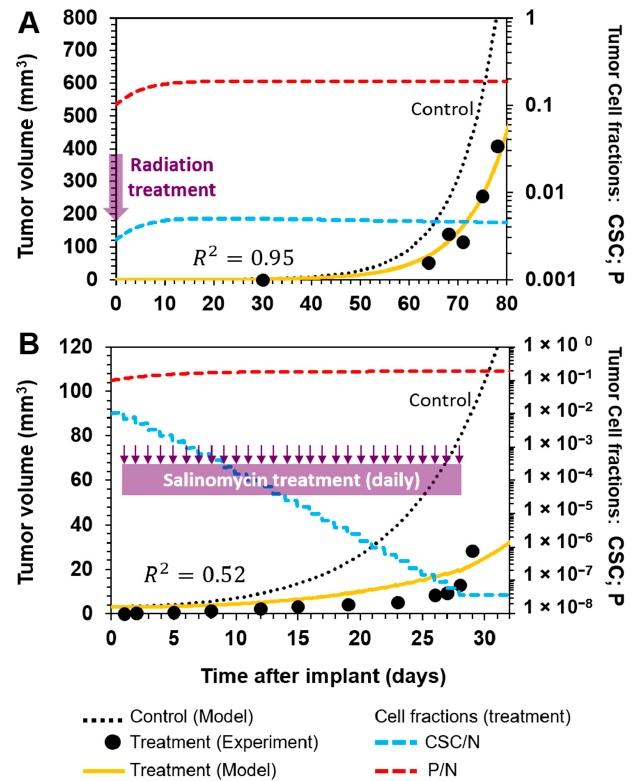
Figure 3. Model fit of experimental treatment scenarios targeting CSCs. ( A ) Radiation-treated cancer cells (3 × 10 4 ) were implanted in the mammary fat pads of mice [14]. This treatment reduced the percentage of CSCs in the inoculation culture. Tumor growth was delayed compared to the control, but the tumor relapsed and the fraction of CSCs increased over time to reach a new equilibrium. ( B ) Breast cancer cells (1 × 10 6 ) were implanted in the mammary glands of mice, which, after 24 h, were then administered daily with salinomycin for four weeks [13]. Selective elimination of CSCs considerably delayed the tumor burden. However, the tumor regrew, despite the elimination of CSCs. Experimental data are represented by black points, model fitting by a yellow line, the control treatment curve by a dashed black line, the CSC fraction by a dashed blue line, and the P fraction by a dashed red line.